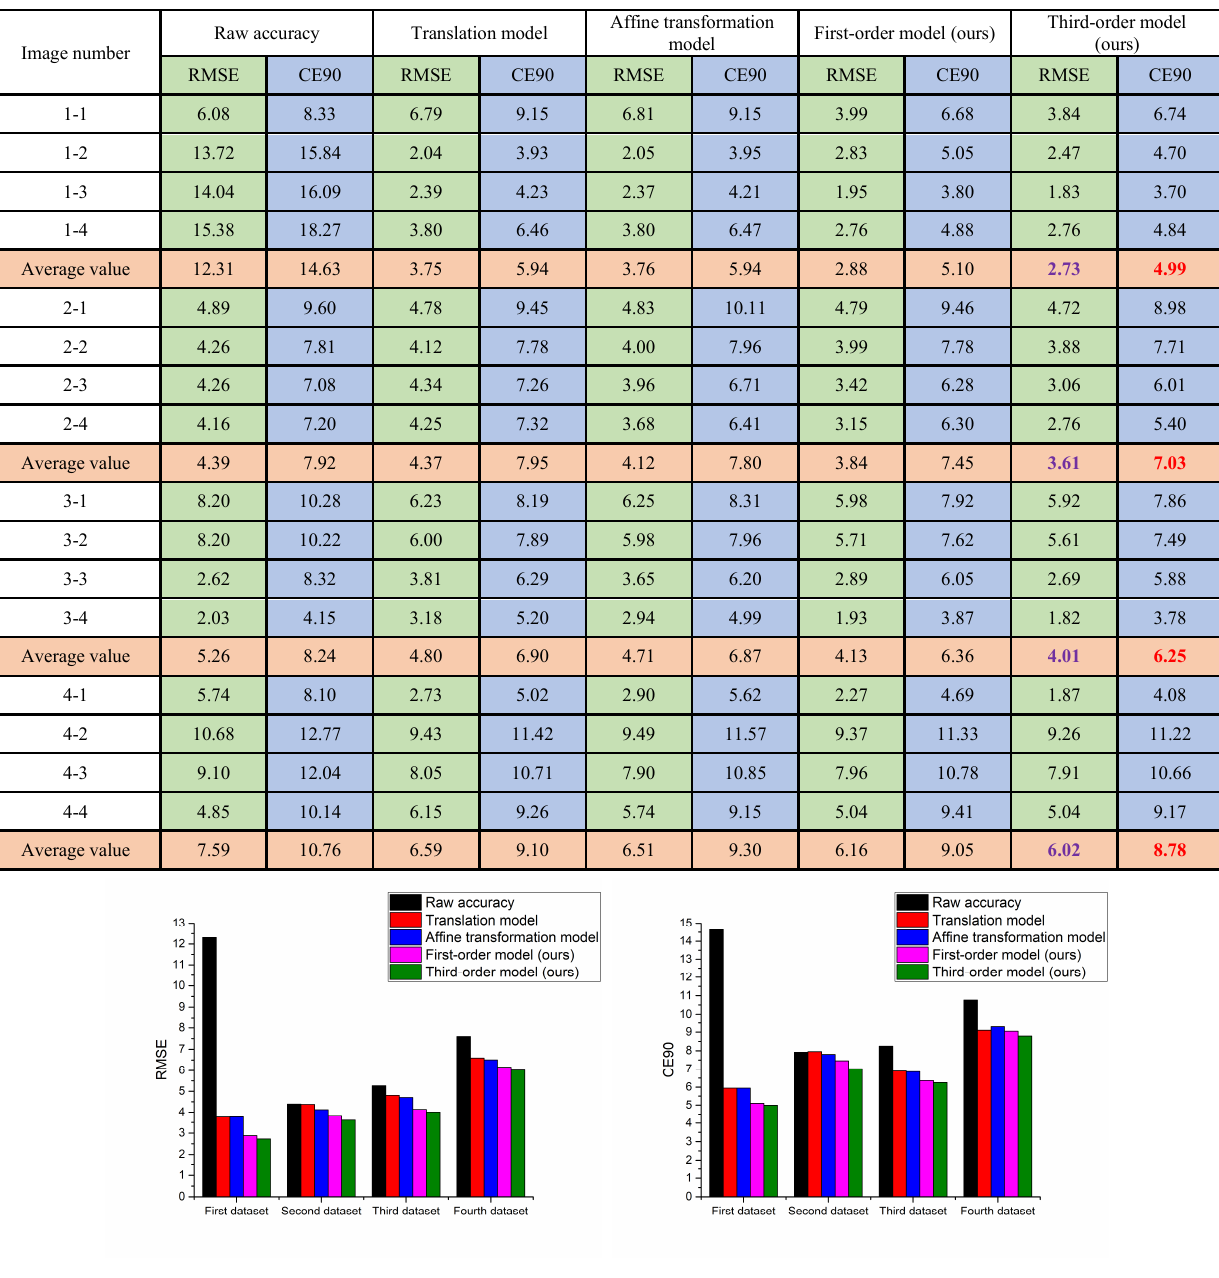
Table 2 Statistics of the correction accuracy of shared model (unit: pixels)